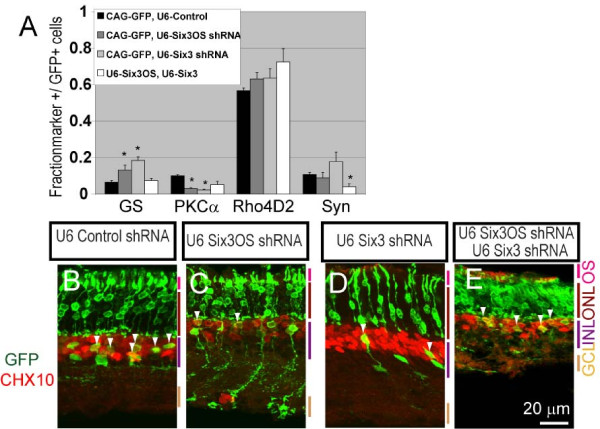
shRNA-mediated knockdown of Six3 and Six3OS in the developing retina alters bipolar cell and Muller glial development. (A) Six3 knockdown and Six3OS knockdown both lead to an increase in Muller glia and a decrease in rod bipolar cells as measured by immunostaining of dissociated electroporated retinal cells. Simultaneous knockdown of both Six3 and Six3OS resulted in a normal number of rod bipolar and Muller glia, but a decrease in syntaxin (Syn)-positive amacrine cells was observed. *P < 0.05. GS, glutamine synthetase. (B-E) Section immunohistochemistry demonstrates a decrease in GFP-positive bipolar cells following knockdown of either Six3OS or Six3, but not both in combination (white arrowheads). Chx10 (ceh-10 homeodomain containing homolog (C. elegans)) was used as pan-bipolar cell marker. GCL, ganglion cell layer; INL, inner nuclear layer; ONL, outer nuclear layer; OS, outer segment.